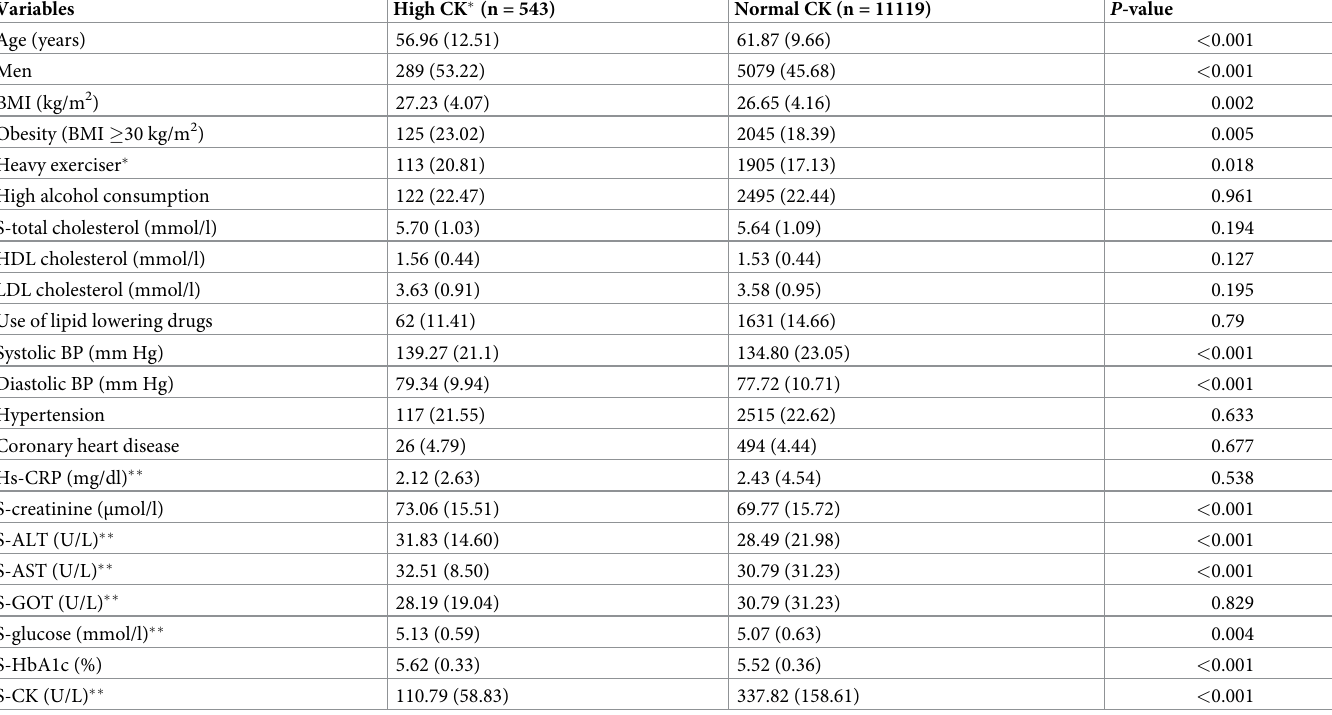
Table 1. Clinical characteristics of the study participants with and without hyperCKemia. Data are presented as mean (SD) or numbers (%).